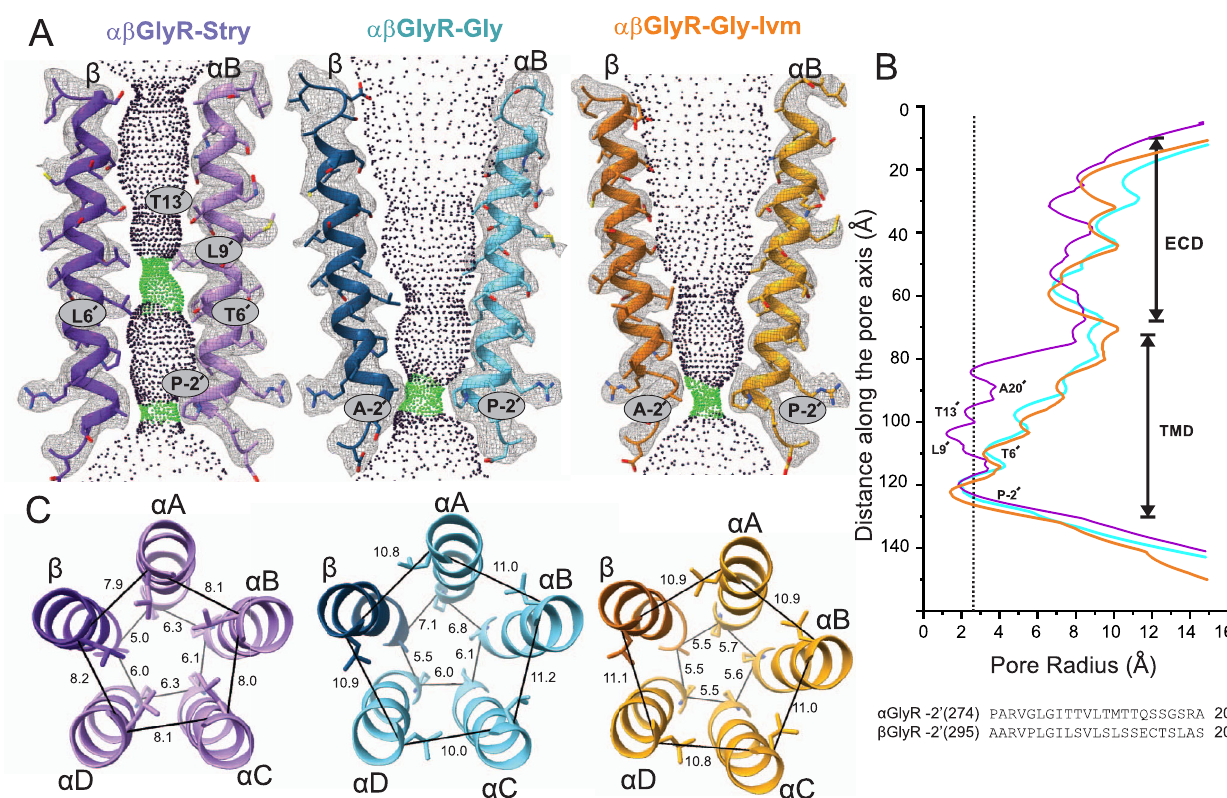
Fig. 2 | Conformational changes within the αβ GlyR pore in response to dif- ferent ligands. A Map and model representations of M2 helices in the α B and β subunits as seen in αβ Gly-Stry, αβ Gly-Gly and αβ Gly-Gly-Ivm ( σ =0.146, 0.25, and 0.13,respectively).Theionpermeationpro fi lesofthechannelporeweregenerated using HOLE 85 . The side chains lining the constrictions (green dots) are labeled. B The smallest pore radii as a function of the position along the pore axis. The